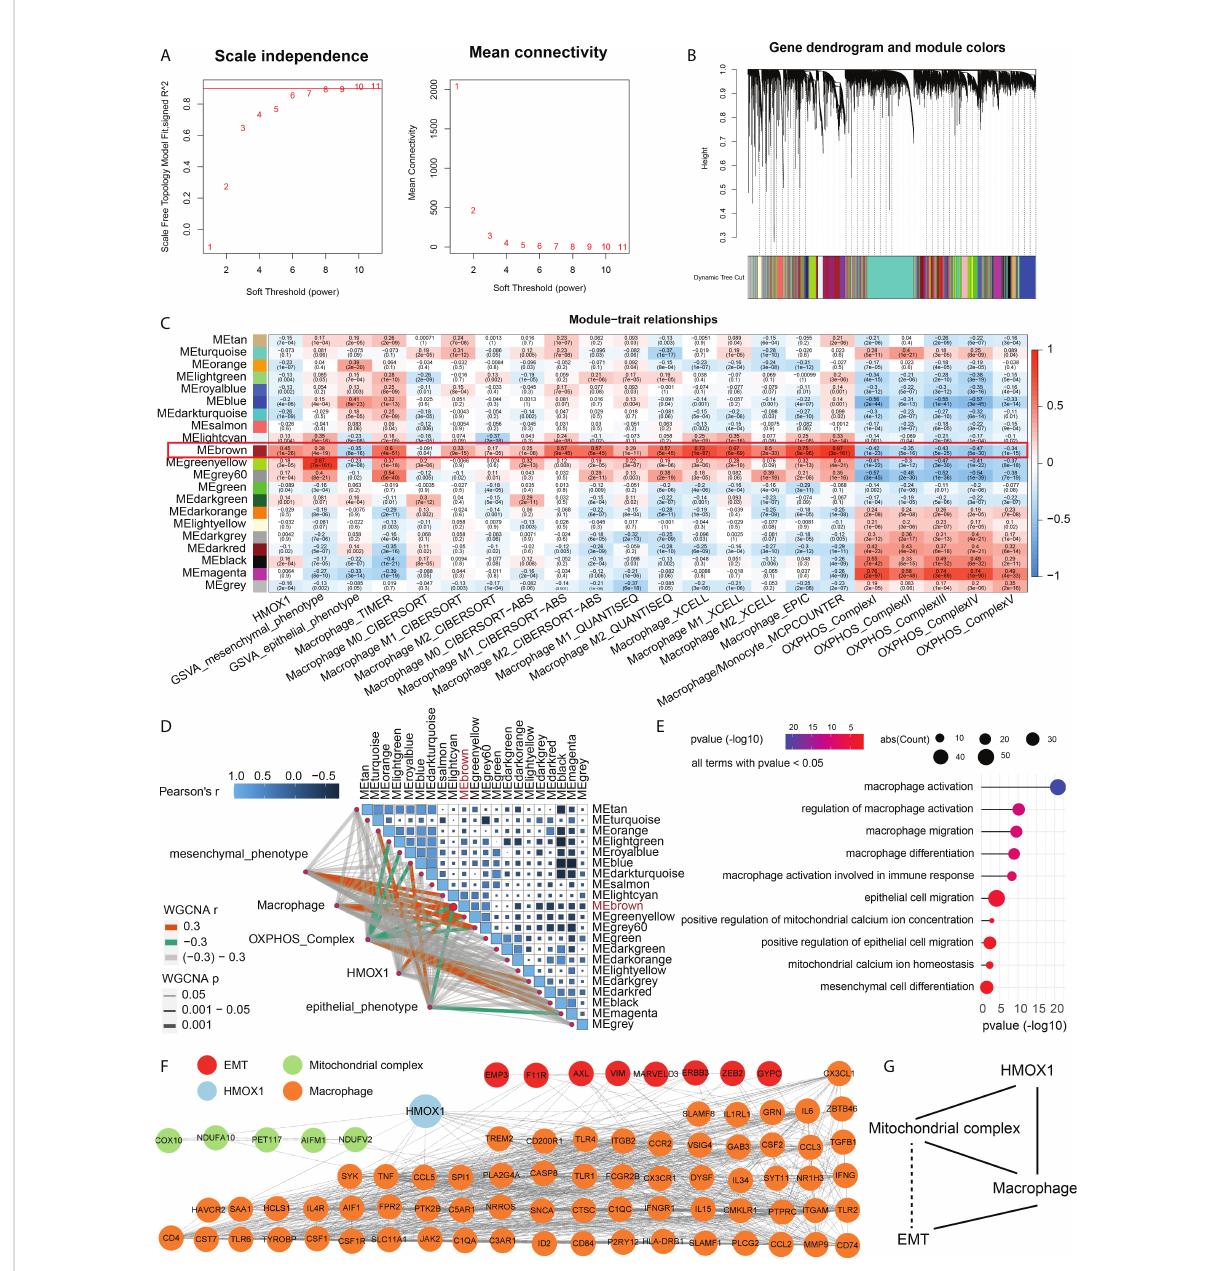
FIGURE 6 Weighted gene coexpression network analysis (WGCNA) for the construction of an HMOX1-mediated metastasis regulatory network in LUAD. (A) A scale-free network construction (power threshold b = 6). (B) Gene dendrogram generating gene modules. (C, D) Correlation analysis between modules and pathophysiological traits. HMOX1, EMT, macrophage, and mitochondrional complex had the same high correlation module (MEbrwon). (E) Gene Ontology (GO) enrichment for the MEbrown genes. (F) The construction of protein-protein interaction (PPI) network among HMOX1, macrophage, mitochondrional complex, and EMT using the MEbrown module genes. (G) The simpli fi ed interaction network among HMOX1, macrophage, mitochondrional complex, and EMT. Solid lines indicate interactions. Dashed lines indicate missing